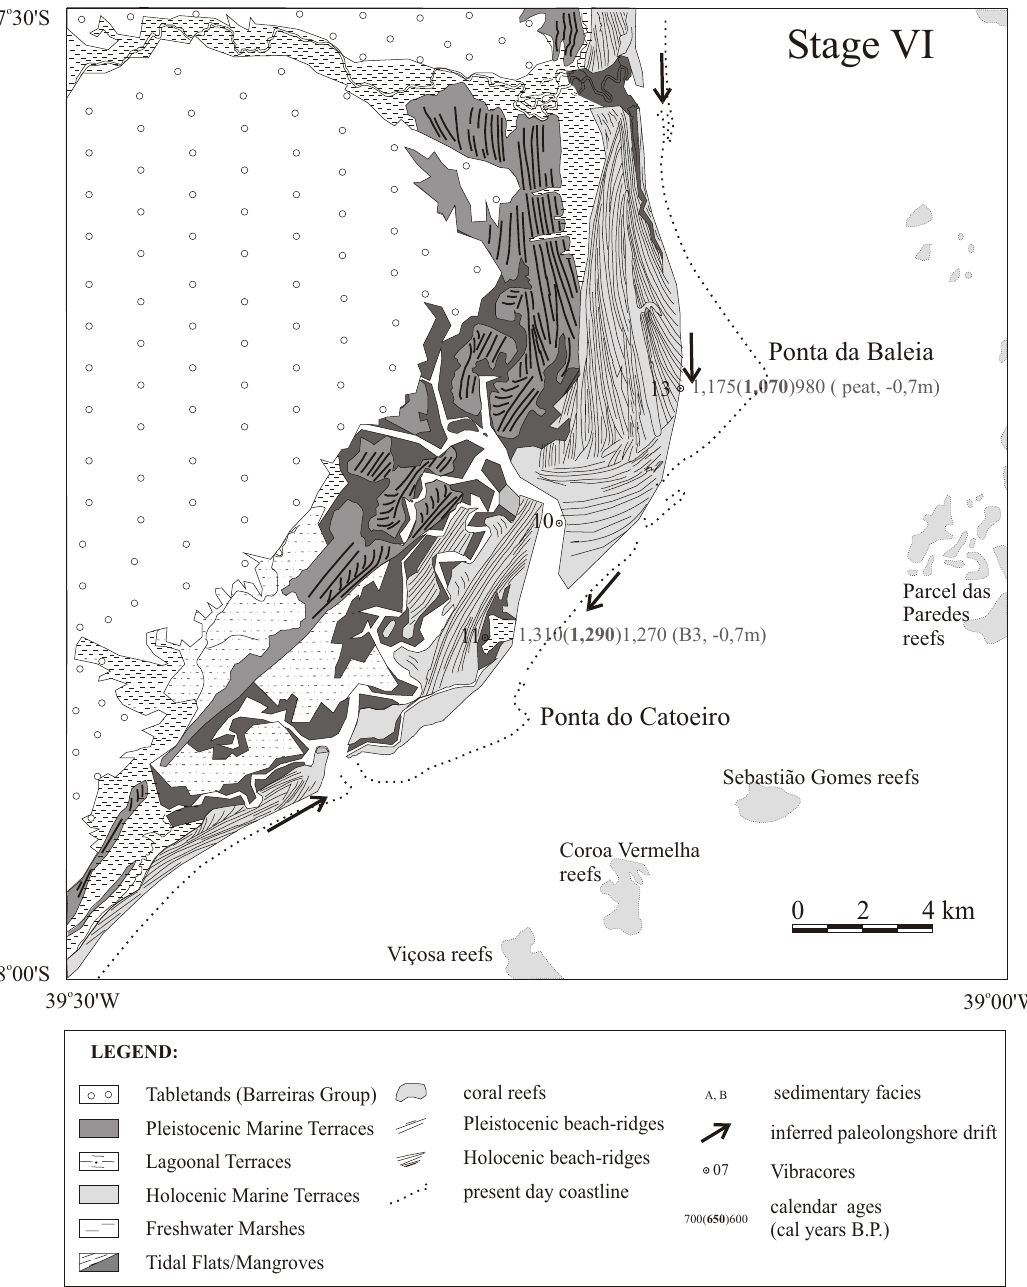
Fig. 14 – Quaternary evolution of the Caravelas strandplain: Stage VI – Severe coastal erosion at Caçumba island.